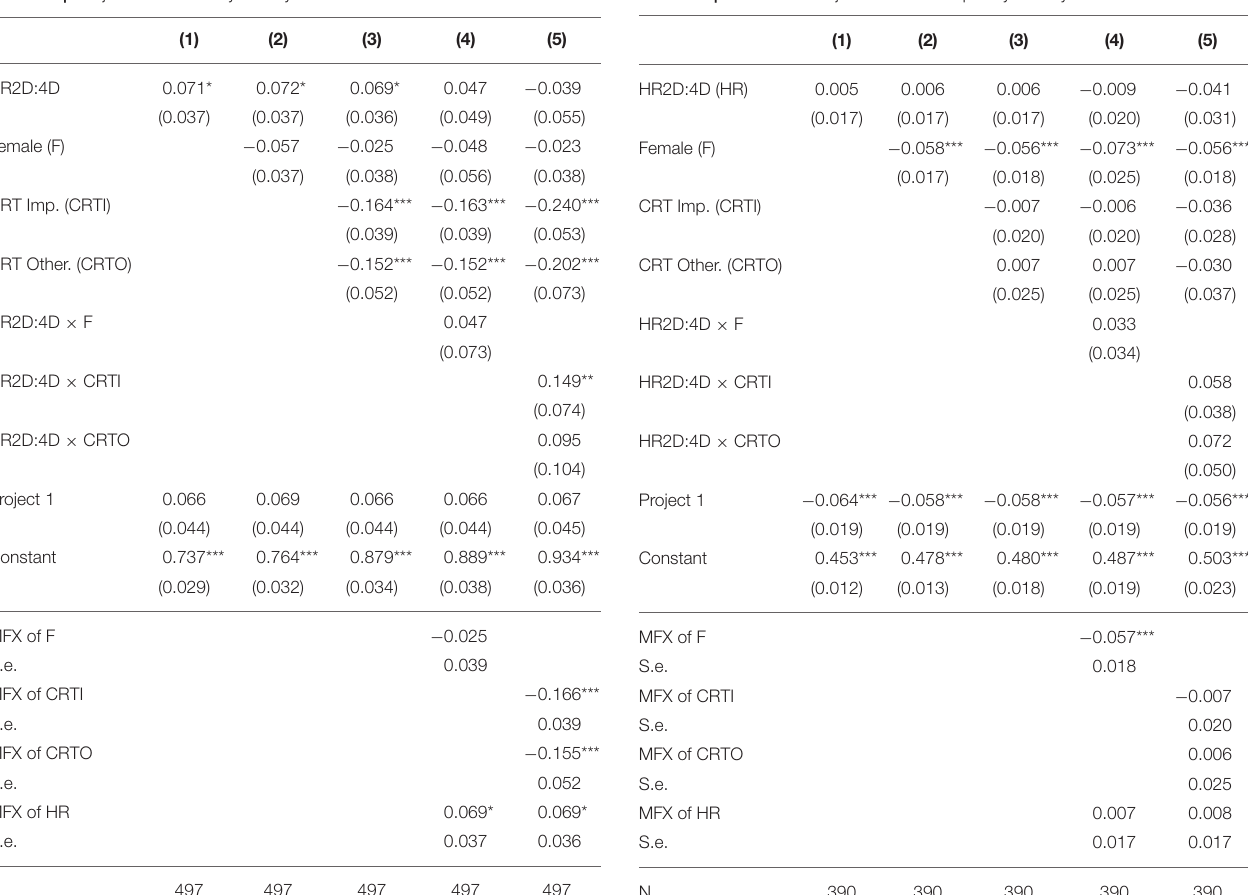
TABLE 4 | Subjects’ consistency in risky choices. TABLE 5 | Consistent subjects’ relative frequency of risky choices above